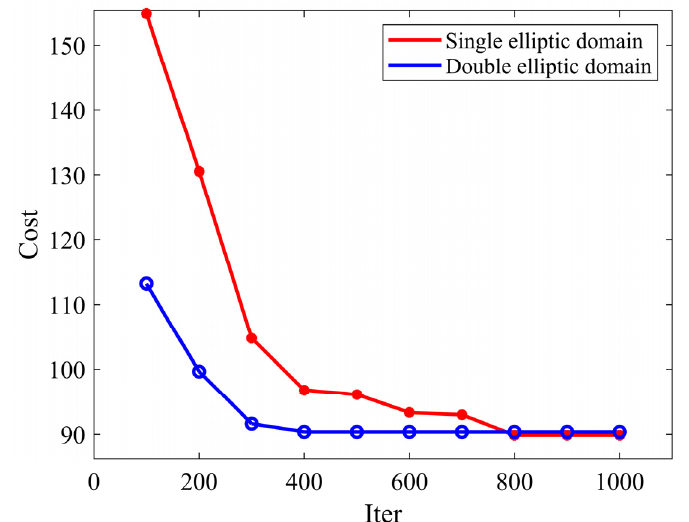
Figure 12. Comparison of the convergence of two elliptic sampling domains in scenario 3.